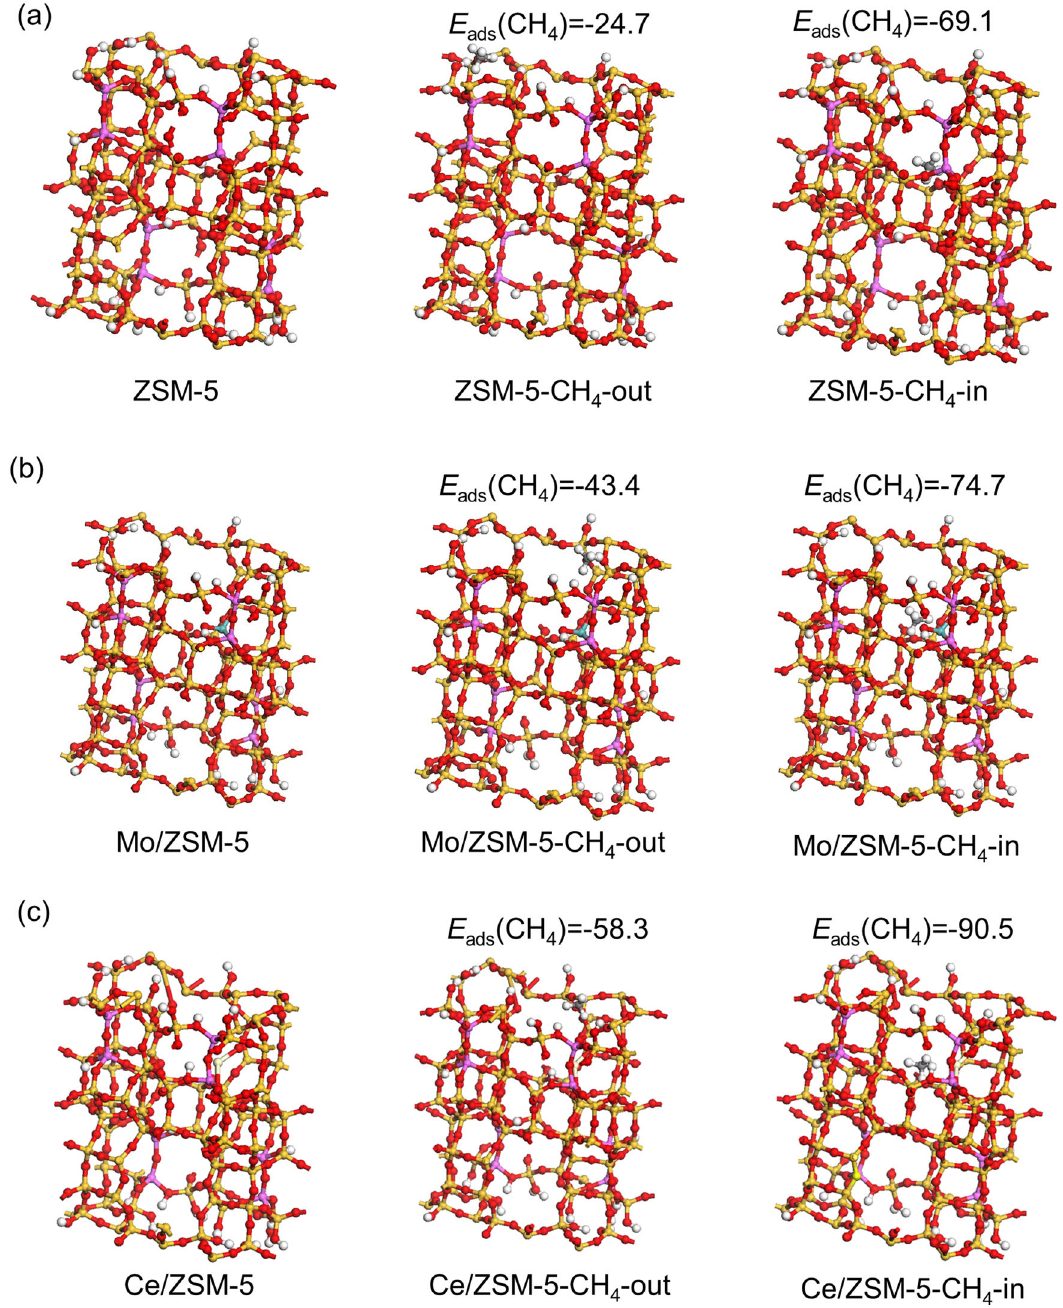
Fig. 5 Optimized structures of catalysts and methane adsorption on the external surface and in the internal pore structure of the zeolitic catalysts through DFT calculation. a ZSM-5 catalyst, b Mo/ZSM-5, c Ce/ZSM-5. Energy unit: kJ mol − 1